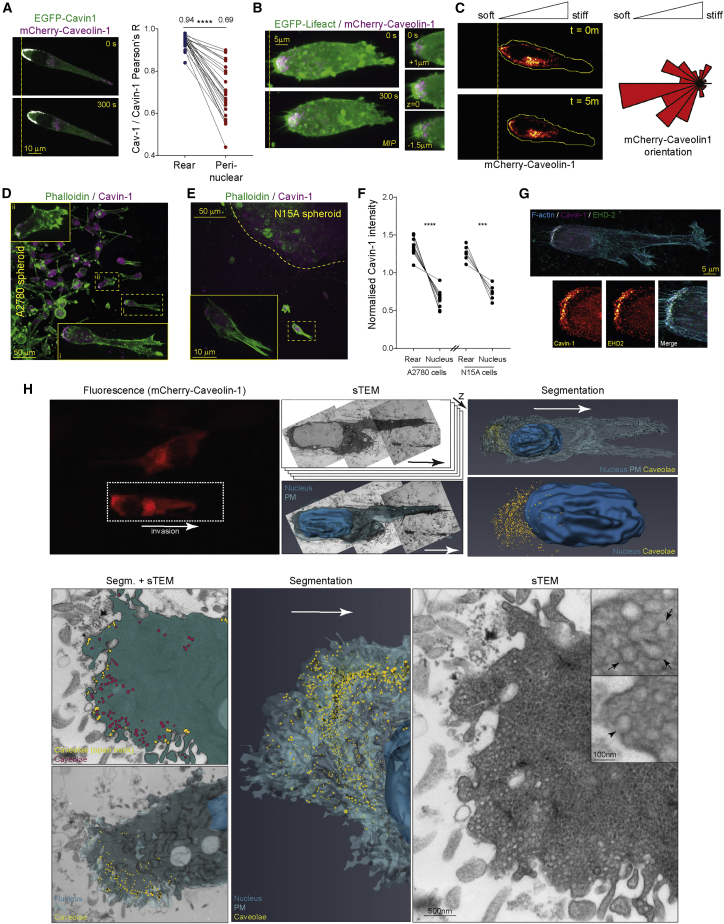
Low Membrane Tension Promotes Caveolae Formation at the Rear of Fast-Moving Cells in 3D and Durotactic Gradients(A) A2780 cells expressing EGFP-cavin-1 and mCherry-caveolin-1 were imaged as in Figure 1A; pairwise Pearson’s correlation coefficient for co-localization of EGFP-cavin-1 and mCherry-caveolin-1 in rear compared to peri-nuclear regions (N=28 cells, mean value above).(B) A2780 cells expressing Lifeact-EGFP and mCherry-caveolin-1 imaged as (A), maximum intensity projection (MIP) shown for whole cell (left), individual Z-slices for rear regions (right).(C) Left: A2780 cells expressing mCherry-caveolin-1 seeded onto 2D durotactic gradients and imaged as in (A), yellow line indicates outline of the cell; right: orientation of caveolae with respect to the gradient shown by rose plot (N=58 cells, 3 repeats).(D and E) A2780 (D) or N15A (E) cell spheroids within collagen and fibronectin hydrogels stained for F-actin (phalloidin) and Cavin-1. Spheroid edge denoted by yellow dotted line; inset: higher-resolution image of the highlighted individual invading cells. MIPs of Z-stacks shown.(F) Pairwise normalized rear and nuclear Cavin-1 intensity in individual invading A2780 and N15 cells (N>8 cells analyzed, 3 repeats).(G) A2780 cell seeded in 3D CDM and fixed and stained for F-actin, cavin-1, and EHD2; whole cell and separately captured zoomed rear MIPs of confocal stacks shown.(H) Serial transmitted electron microscopy (sTEM, 100-nm sections) of A2780 cell expressing mCherry-Caveolin-1 in CDM. Manual segmentation of the nucleus, the plasma membrane and caveolae are displayed as a 3D model over the entire cell. Both caveolae connected to the plasma membrane (yellow) and caveolae-associated vesicles (pink) were segmented (segm. + sTEM image). Both structures were merged in yellow in the overall model. An individual sTEM image is presented. Insets show higher-resolution images of multilobed (arrows) or membrane-attached (arrowhead) caveolae (different z-section of the same cells). Scale bar, 500 nm (inset: 100 nm). ∗∗∗p < 0.001; ∗∗∗∗p < 0.0001. See also Figure S2 and Videos S3 and S4.